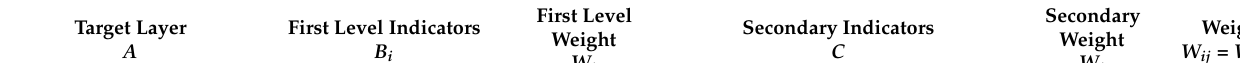
Table 2. Comprehensive weight table of comprehensive benefits of green buildings evaluation